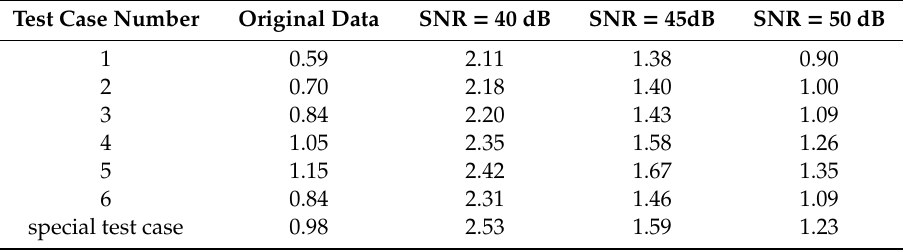
Table 4. Reconstruction errors (%) in seven test cases with a 0.3% sample rate (12 sensors).